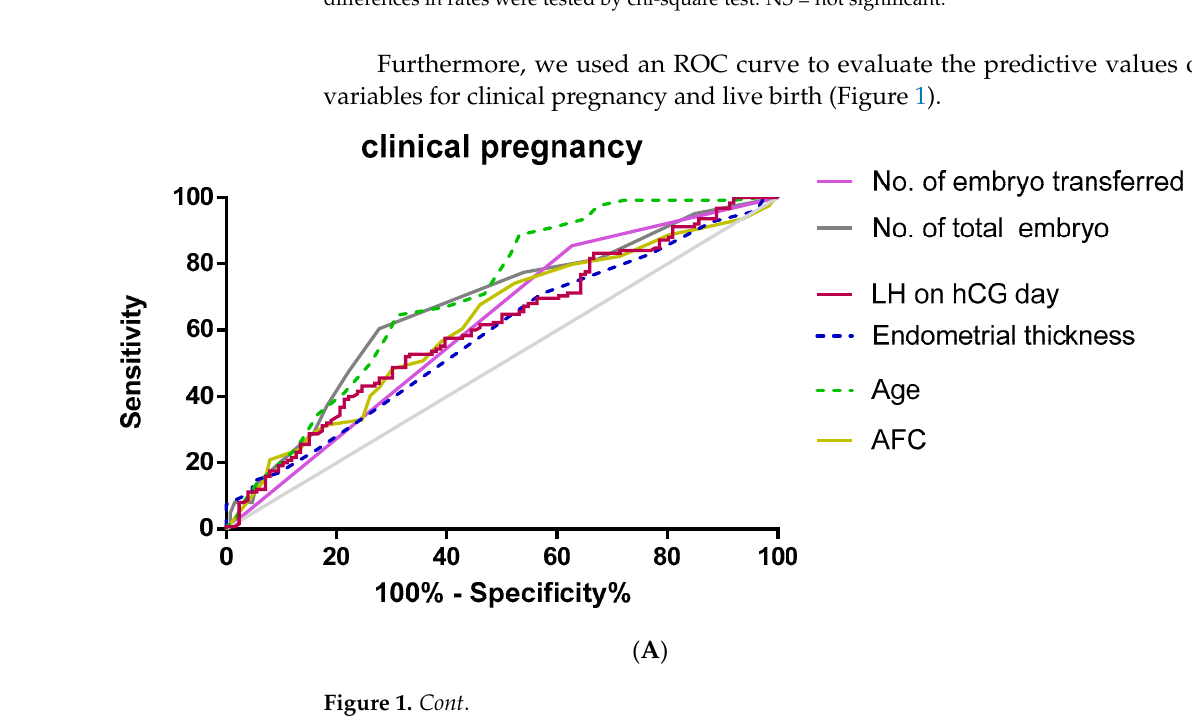
Table 2. Patient and cycle characteristics by pregnancy outcome.